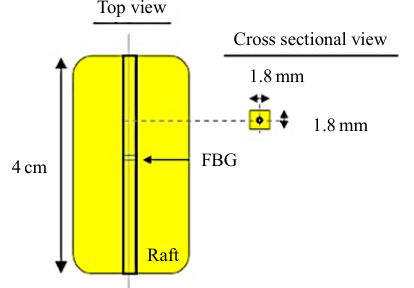
Fig. 1 Illustration (showing key dimensions) of the embedded FBG-based strain sensor designed in this